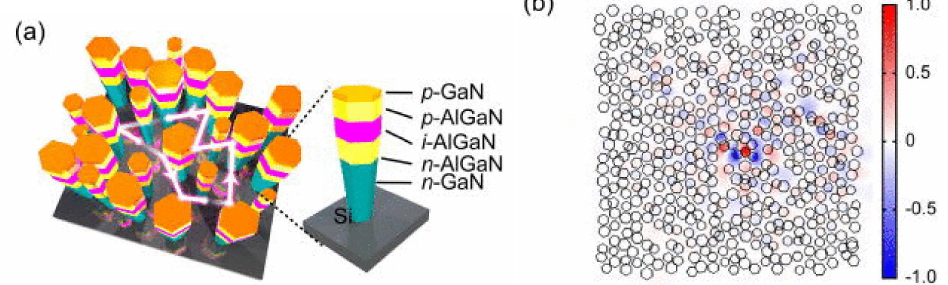
Figure 18. ( a ) Schematic of a random cavity inside AlGaN nanowire arrays; ( b ) simulation result of the electric field for a high-Q cavity formed by AlGaN nanowires. Reproduced from [150], with permission from Copyright American Institute of Physics,